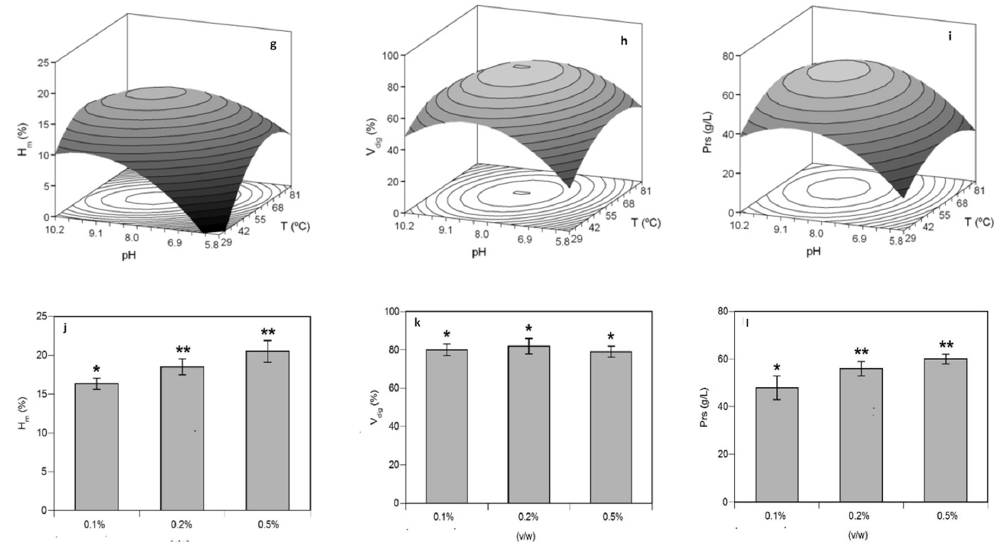
Figure 1. Optimization studies of Sb_He ( a – f ) and Sbass_He ( g – l ) hydrolysis by endogenous Alcalase. Theoretical response surfaces describe the joint effect of pH and T on H m ( a , d , g , l ), V dig ( b , e , h , k ) and Prs ( c , f , i , l ) variables. Histograms show the individual effect of Alcalase concentration on the same variables. Error bars are the intervals of confidence for n = 2 (replicates of different hydrolysates) and α = 0.05. Different asterisks in each histogram-graph means statistically significant differences ( p < 0.05). Once the optimal proteolysis conditions were established for seabream and seabass heads, the process was upscaled to 5 L reactors and applied to heads, trimmings and viscera of both species. At the end of the enzymatic reaction, a solid fraction (mainly bones) was separated from the raw FPH (Figure 2). Subsequent centrifugation of this liquid phase allowed the recovery of fish oil after separation of the aqueous phase by decanting, which underwent thermal inactivation and drying to result in the final FPH product.